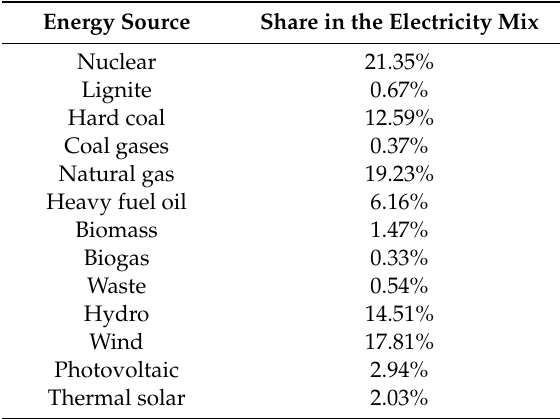
Table 1. The mix of energy sources for electricity generation in Spain (2016) [36].